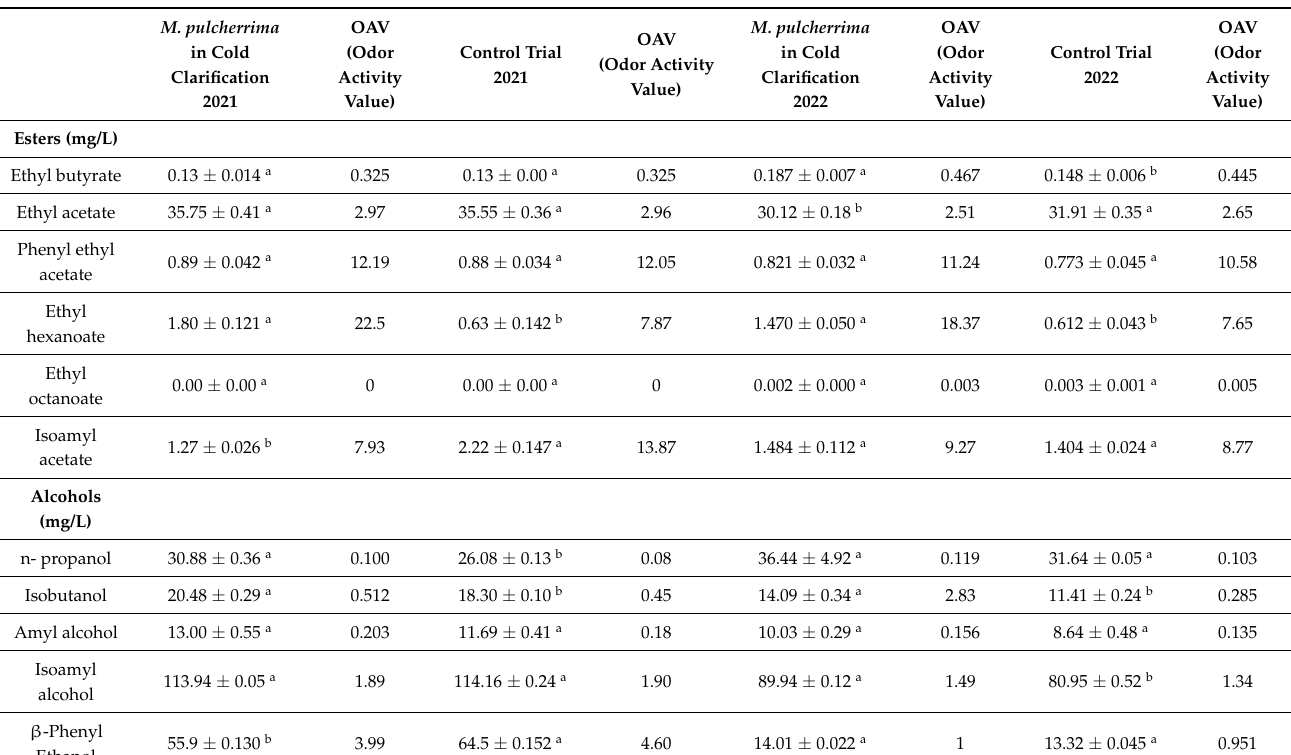
Table 3. The main by-products and volatile compounds in final wines during two vintages